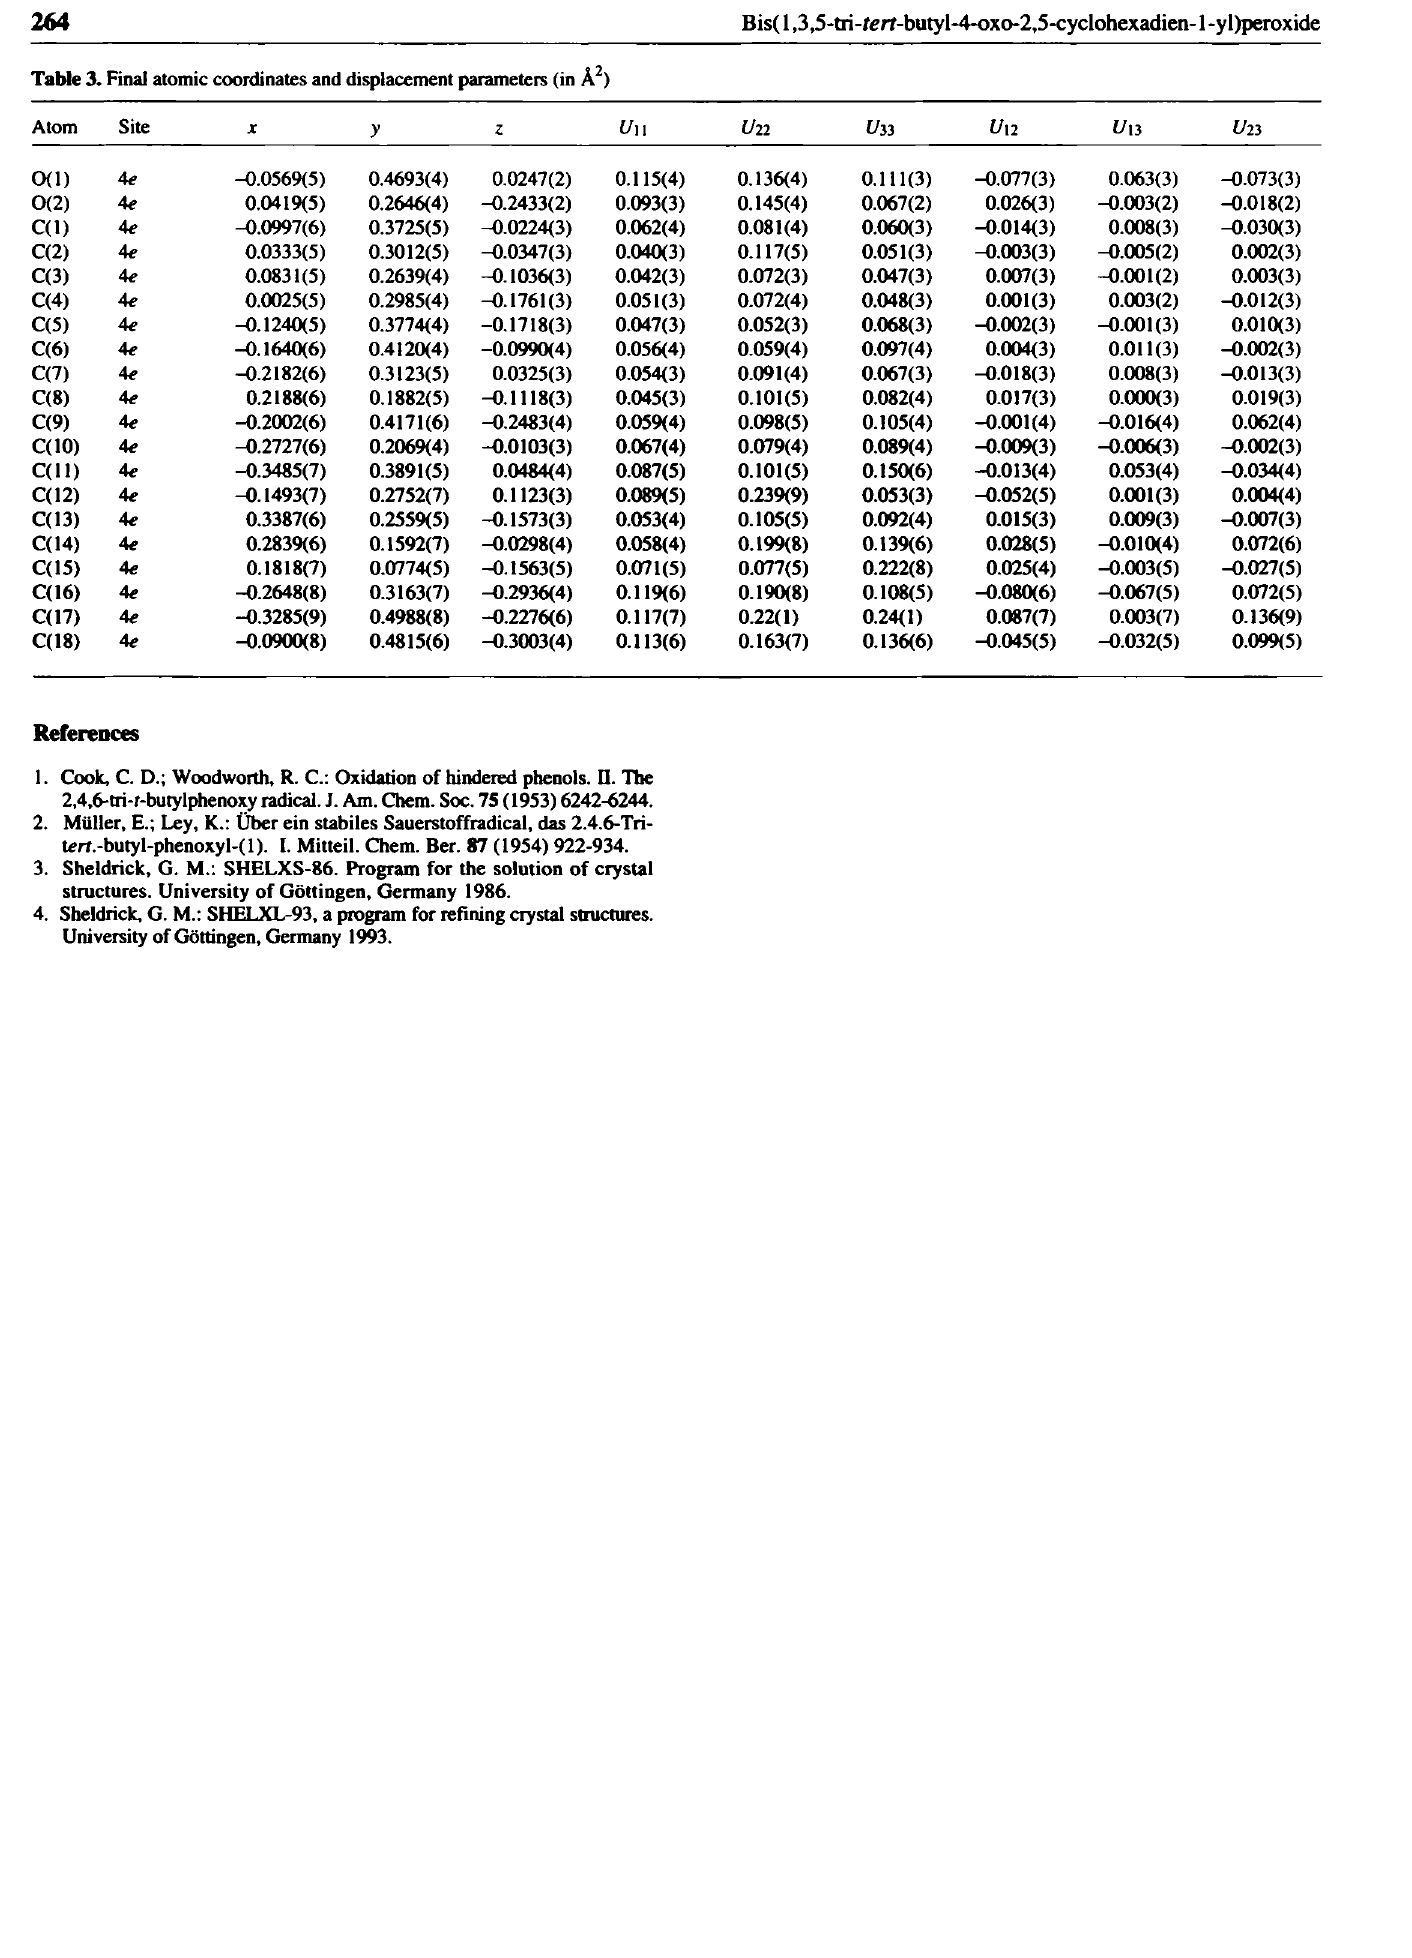
Table 3. Final atomic coordinates and displacement parameters (in Â 2 ) Atom